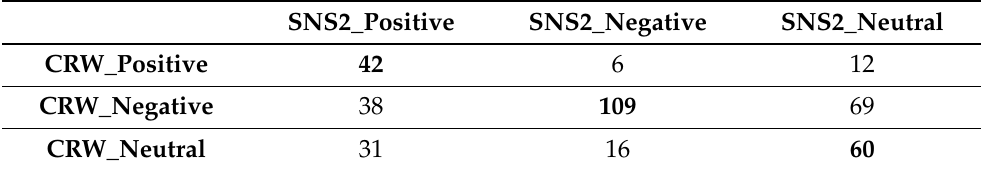
Table 7. Confusion matrix: SNS2 vs.